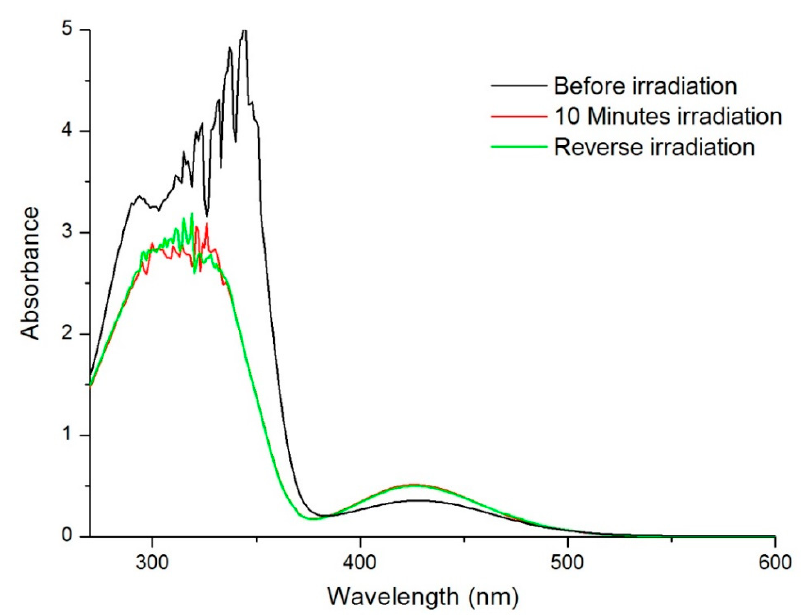
Figure 8. UV-vis spectra of IgG loaded AZP nanosphere dispersion post-irradiation at different time points.